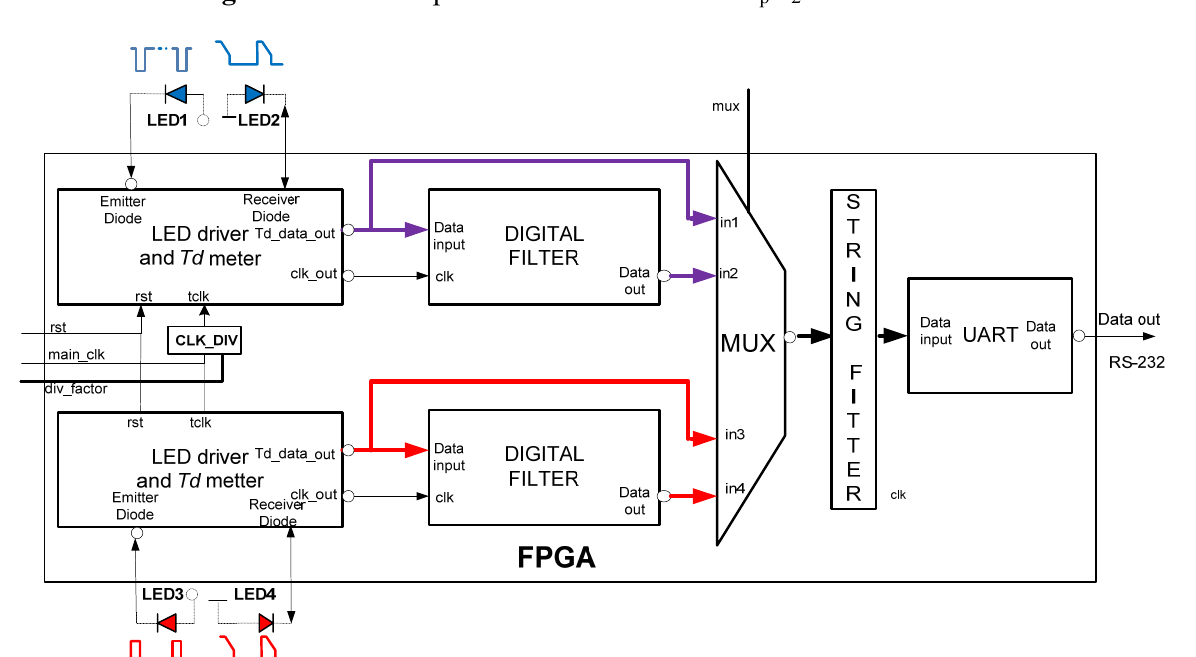
Figure 6. FPGA implementation of PPG and S